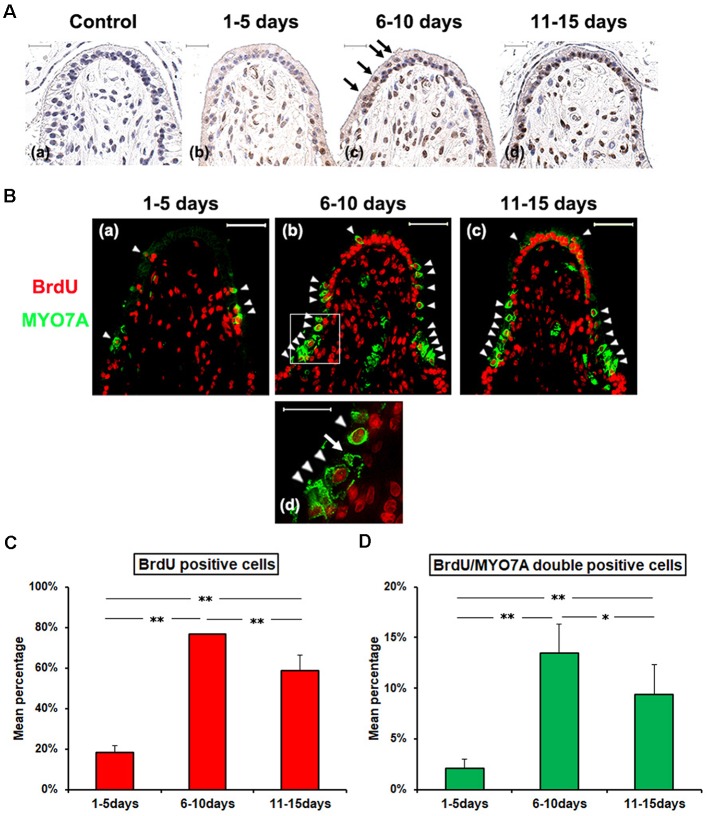
(A) Histopathologic evaluation of cellular proliferative activity with Bromodeoxyuridine (BrdU) infusion after GM treatment. Animals were divided into three groups by the BrdU infused period; 1–5 days (b), 6–10 days (c), and 11–15 days (d) PT. All animals were euthanized at 28 days PT. At 6–10 days PT and 11–15 days PT, many SCs with BrdU-positive nuclei were shown in the basal cell layer, and some BrdU positive cells were shown at the upper luminal portion of the epithelial layer (c). (B) Fluorescence immunohistopathologic evaluation. Green represents anti-MYO7A labeling HC, and red represents anti-BrdU labeling, and white arrow heads point to a BrdU/MYO7A double-positive cells at the upper luminal portion of the epithelial layer. In specimens from the group dosed with BrdU on 1–5 days PT, there were few BrdU-positive cells detected in the sensory epithelium (a). In the groups dosed on 6–10 days PT or on 11–15 days PT, a multitude of SCs with BrdU-positive nuclei were noted in the basal cell layer and also there were cells with BrdU taken up into their nuclei in the sensory cell layer (b,c). The lower panel (d) magnifies the boxed area in the respective upper panel (b). Scale bar = 50 μm. (C) The Mean percentage (Mean ± SD) of BrdU positive cells in the sensory epithelium. (D) The Mean percentage (Mean ± SD) of BrdU/MYO7A double-positive cells in the sensory epithelium. Both of BrdU positive cells and BrdU/MYO7A double-positive cells, there were significant differences among the three groups, with the highest value for the group dosed BrdU on 6–10 days PT. **p < 0.01, *p < 0.05.